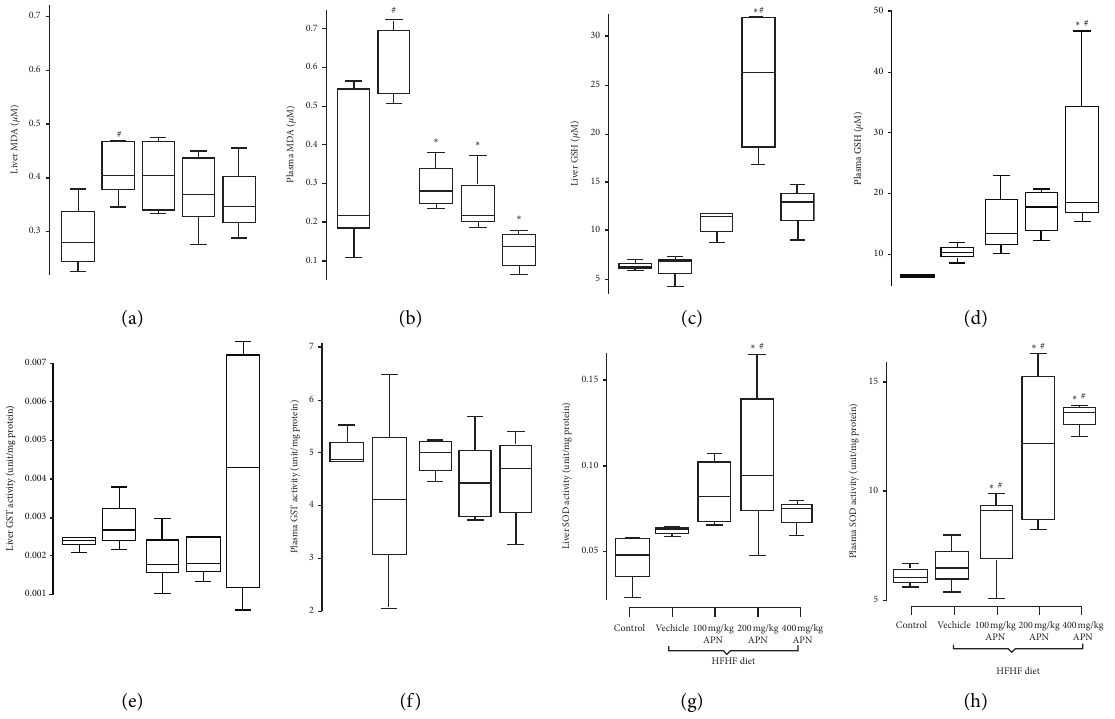
Figure 4: Effect of APN on MDA concentration and antioxidant parameters of rats fed an HFHF diet. (a) MDA level in liver homogenates; (b) MDA level in plasma samples; (c) GSH level in liver homogenates; (d) GSH level in plasma samples; (e) GST activity in liver ho- mogenates; (f) GST activity in plasma; (g) SOD activity in liver homogenates; (h) SOD activity in plasma samples Bars with # are sig- nificantly ( P < 0 . 05) different from control while bars with ∗ are significantly different ( P < 0 . 05) from HFHF-fed